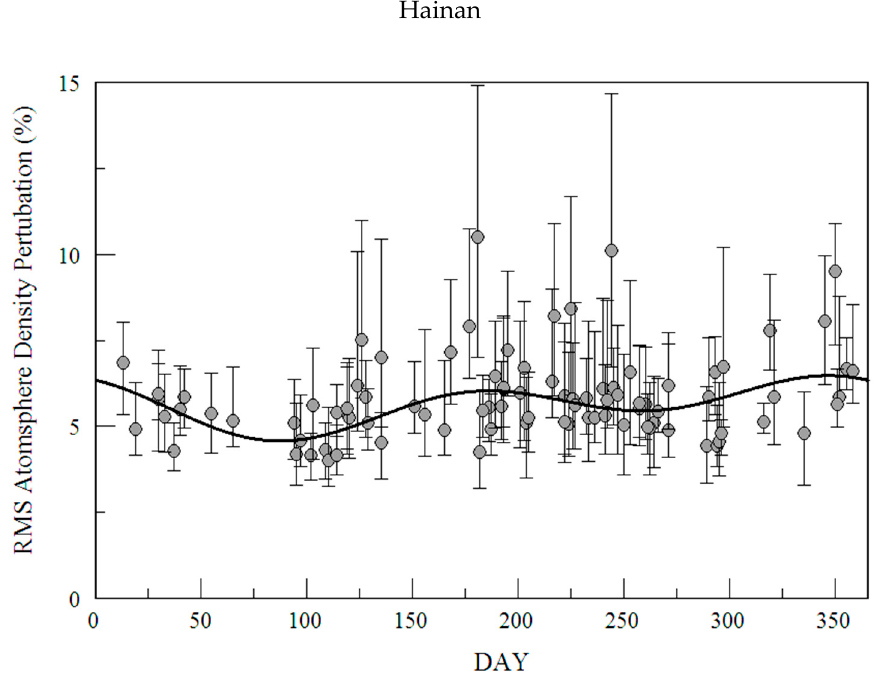
Figure 1. Seasonal variations of the RMS atmospheric density perturbations with their MMSE fit at Beijing ( top ), Hefei ( middle ) and Hainan ( bottom ).